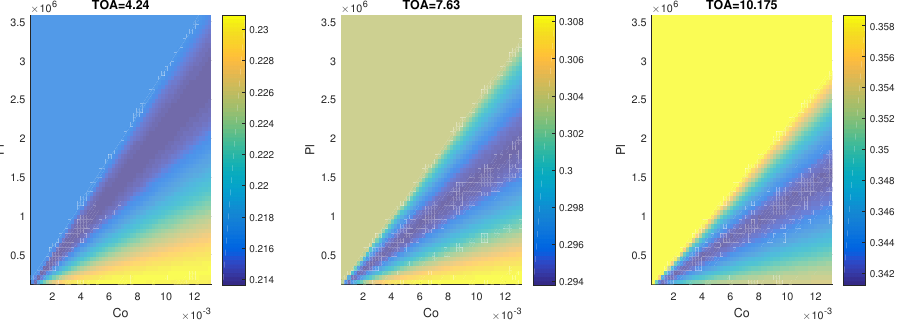
Figure 8. Average value of the mass flow rate oscillations as a function of Co and Pl for different values of TOA